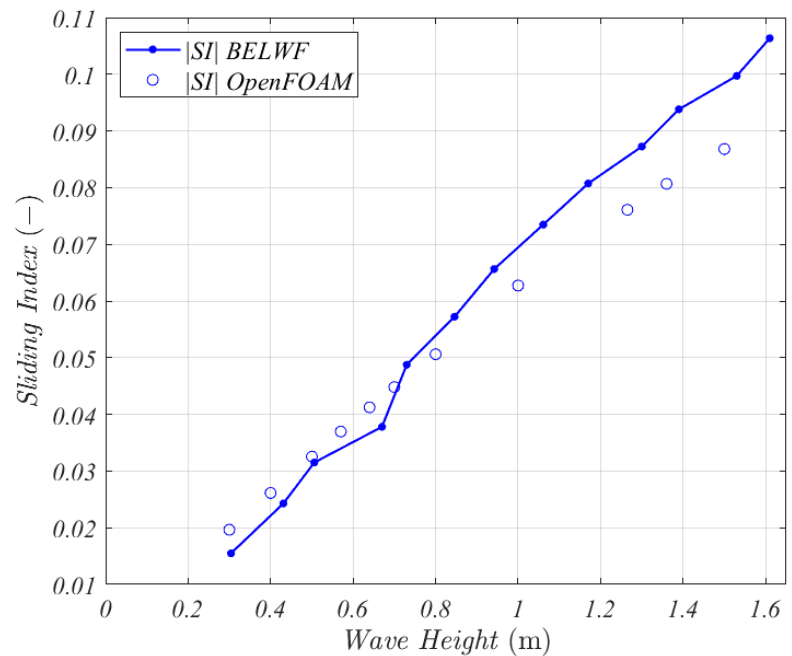
Figure 6. A comparison of the SI, versus wave height; between BELWF and